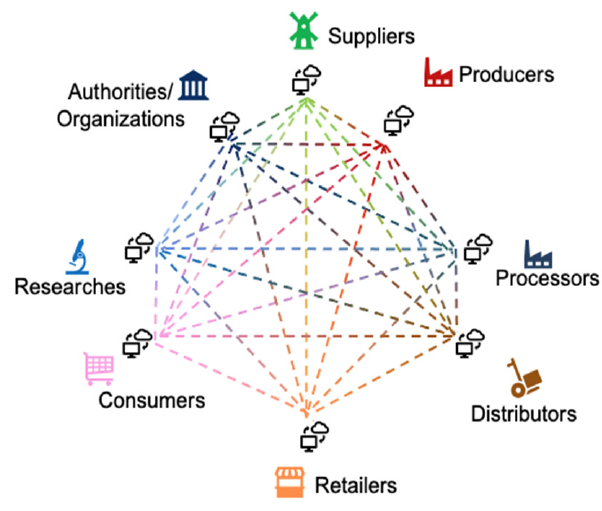
Figure 2. Interoperability network through food system [28].